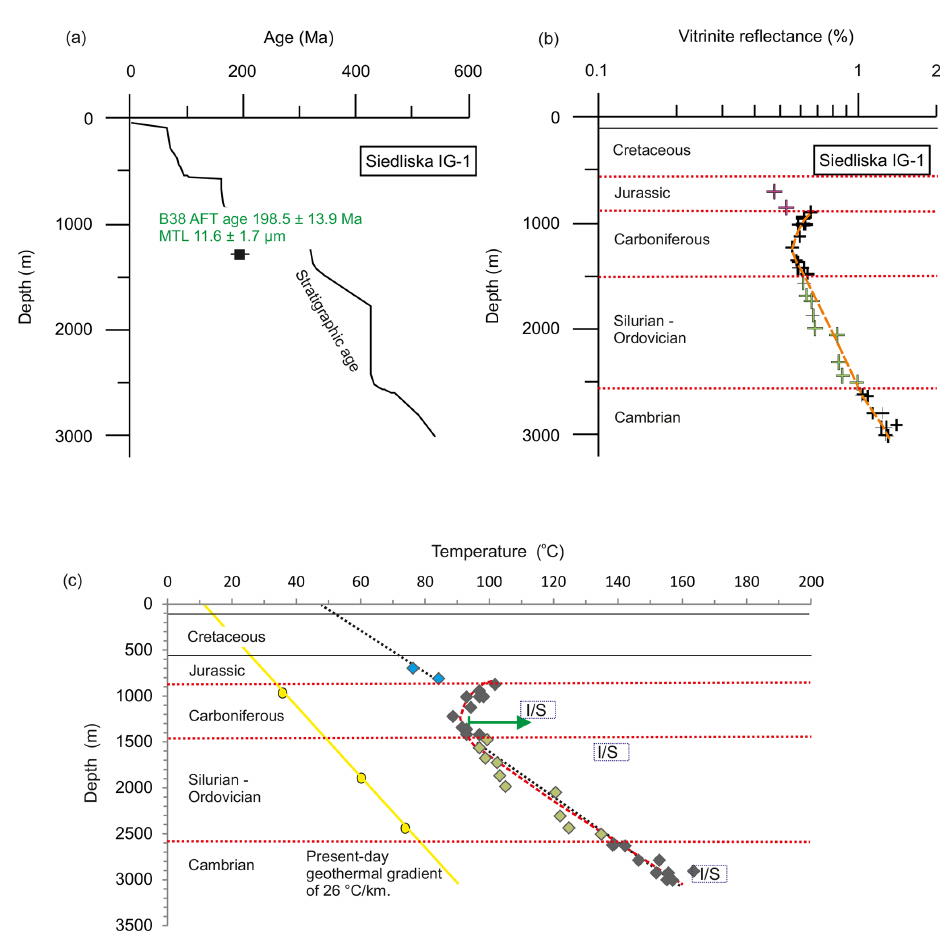
Figure 10. Siedliska IG-1 borehole data (Lublin Basin). (a) Thermochronological data vs. stratigraphic age, (b) VR profile, (c) paleotemper- ature profile. VR and paleotemperature profiles suggest that the fluid flow event is responsible for the pattern revealed. Other explanations are as in Figs. 6 and 7. Illite K-Ar ages from Silurian bentonites are 344–336Ma (early Carboniferous) in the adjacent Wojcieszków-1 well (Kowalska et al., 2019).